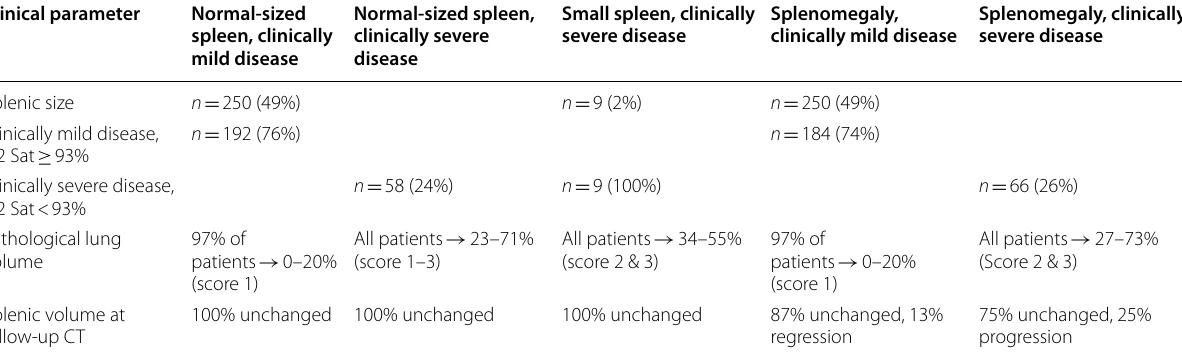
Table 2 Clinical parameters in patients with small, normal-sized and enlarged spleens, respectively, with clinically mild or severe Covid-19 infection Clinical